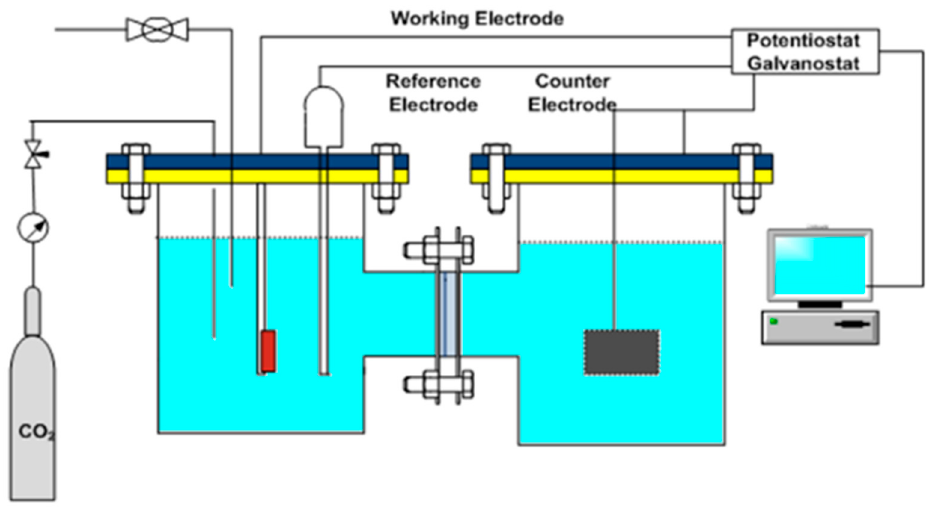
Figure 9. Schematic diagram of half-cell assembly.